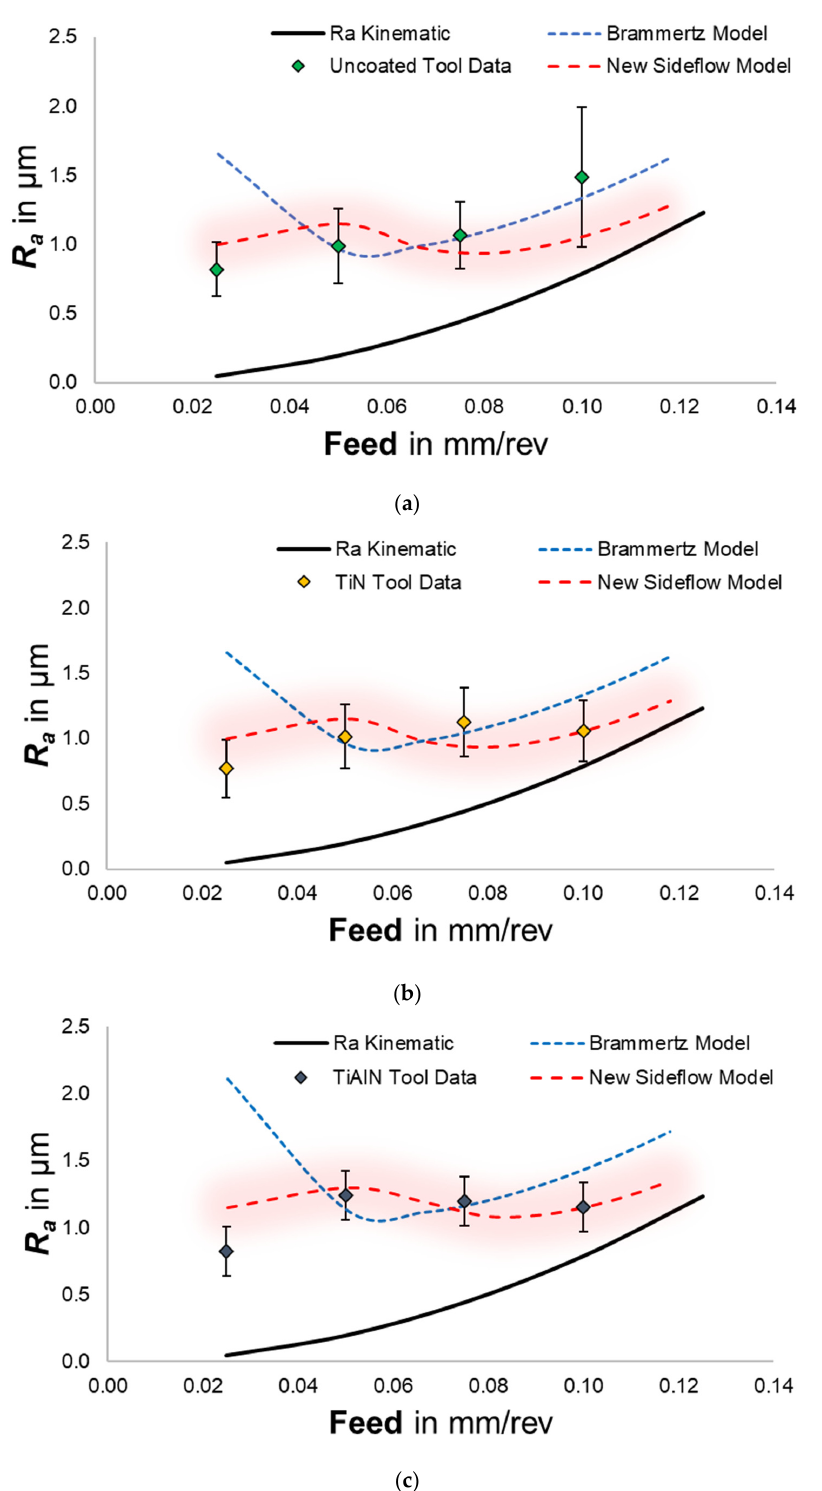
Figure 7. Arithmetic mean surface roughness ( R a ) plots of experimental data for ( a ) Uncoated, ( b ) TiN-coated and ( c ) TiAlN-coated tools, including modeling of theoretical / kinematic roughness (black lines) and increased roughness, due to elastic springback (blue dashed lines) and the proposed plastic sideflow model (red dashed